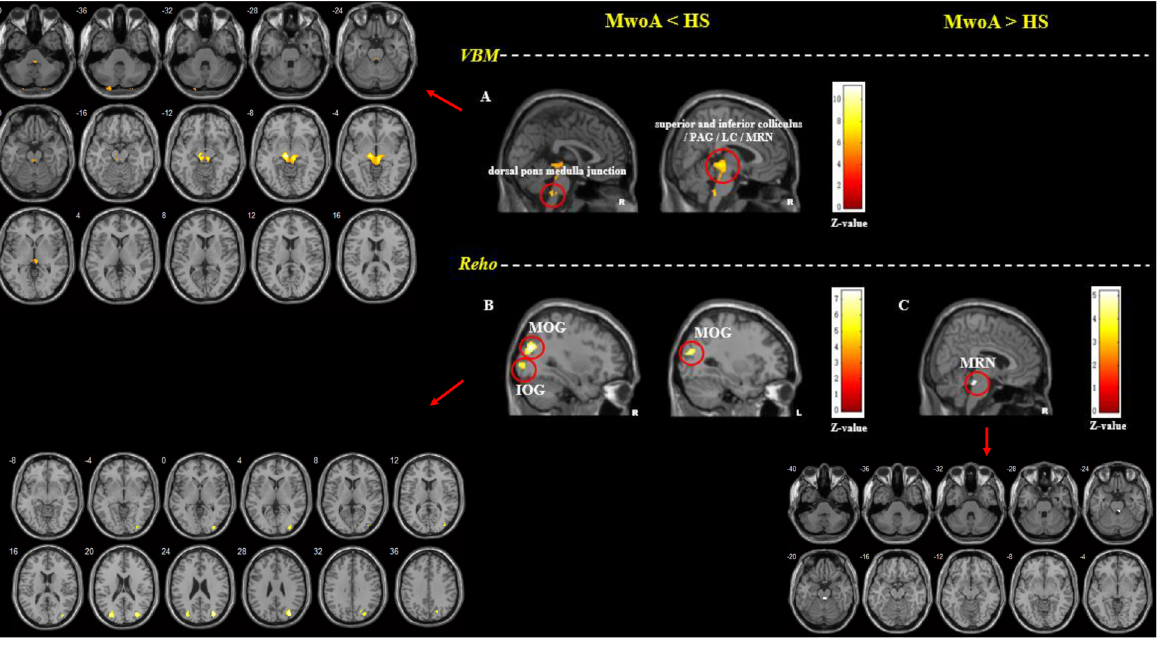
Fig. 1 The VBM and Reho comparisons between MwoA patients and healthy subjects. a . MwoA patients showed lower gray matter volumes in the bilateral superior and inferior colliculus, PAG, LC, MRN and dorsal pons medulla junction compared to HS; b . MwoA patients showed lower Reho values in the right MOG and bilateral IOG compared to HS; c . MwoA patients showed higher Reho values in bilateral MRN compared to HS. A threshold of P < 0.05 family wise error (FWE) correction at cluster level were applied for all comparisons. HS, healthy subjects; IOG, inferior occipital gyrus; L, left side; LC, locus ceruleus; MOG, middle occipital gyrus; MwoA, migraine without aura; PAG, periaqueductal gray; R, right side; Reho, regional homogeneity; MRN, median raphe nuclei; VBM, voxel-based